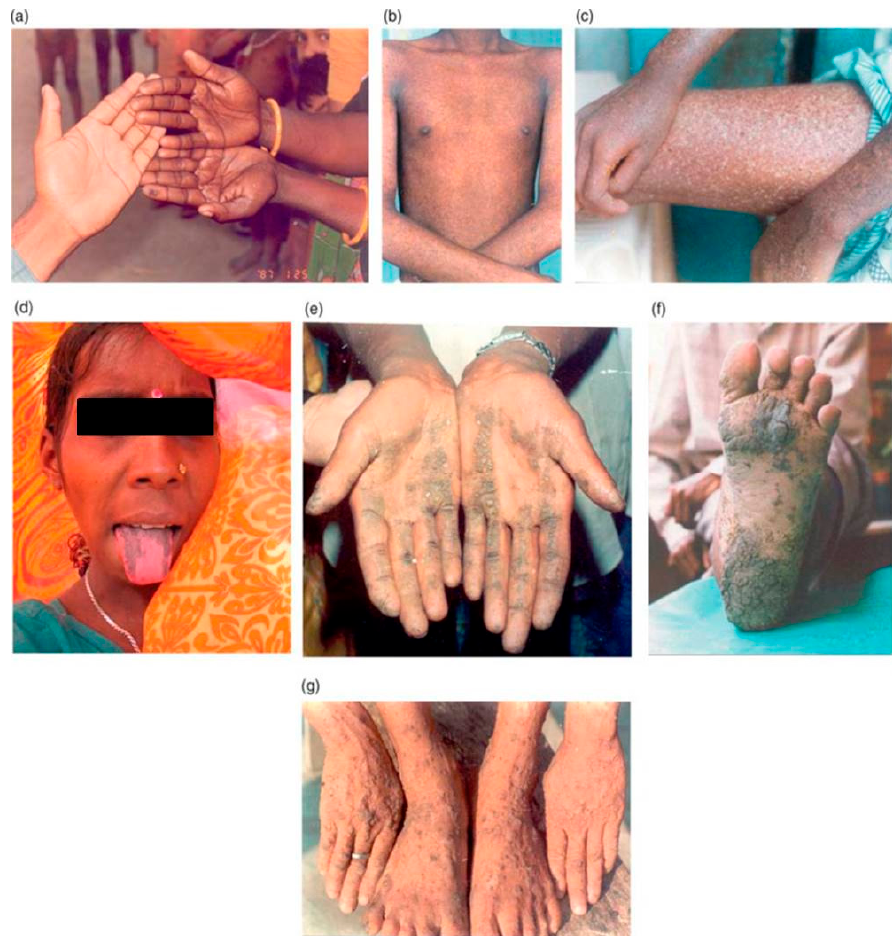
Figure 2. Different skin symptoms due to arsenic toxicity: ( a ) diffuse melanosis; ( b ) spotted melanosis; ( c ) leucomelanosis; ( d ) tongue melanosis; ( e ) diffused and nodular keratosis on the palm; ( f ) spotted keratosis on the sole; and ( g ) dorsal keratosis.